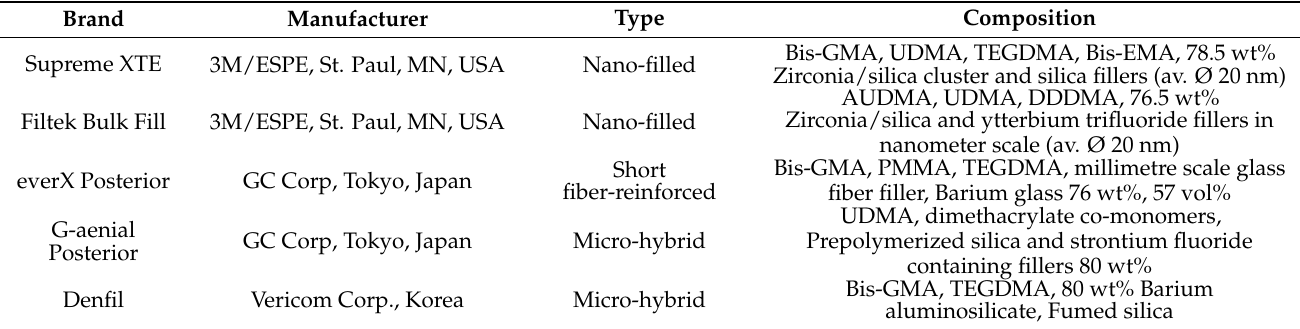
Table 1. The packable resin composites tested in this